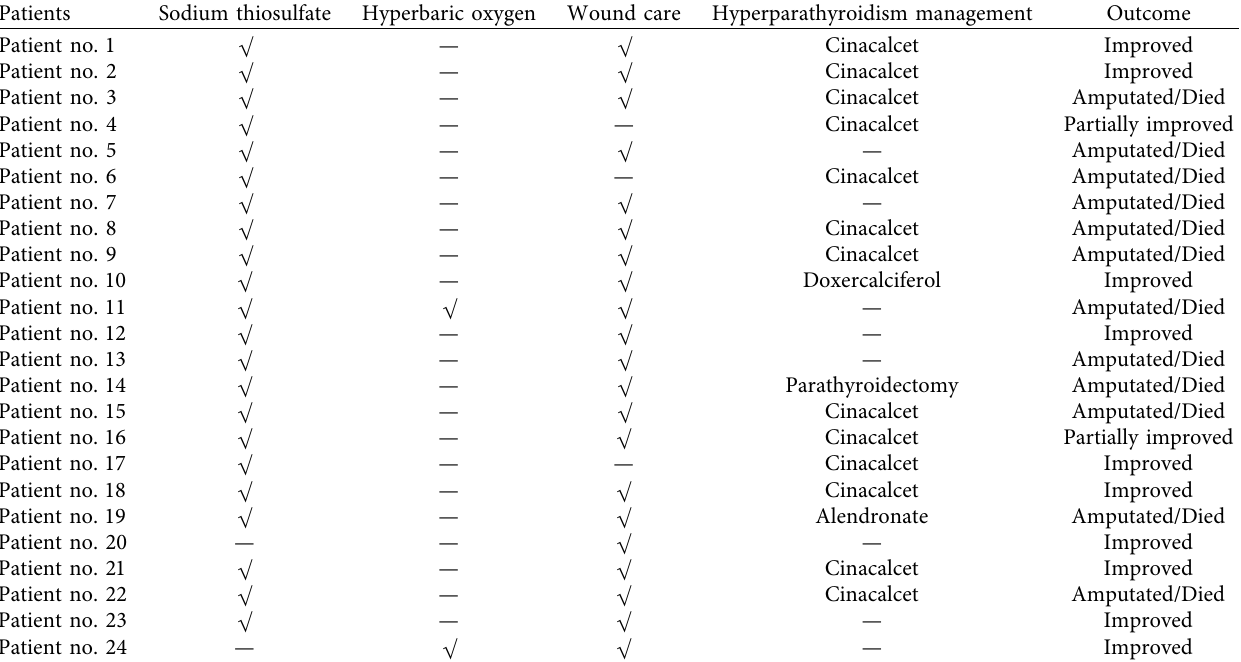
Table 6: The relationship of multifaceted regimens of our patients and their final outcomes. Patients Sodium